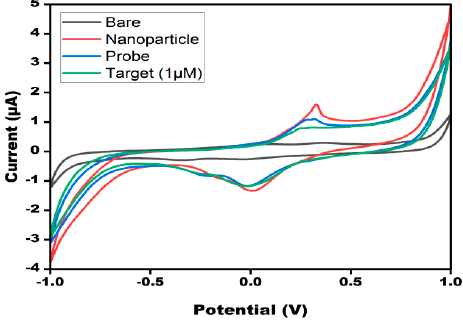
Figure 1. ( a ) XRD diffractogram and ( b ) UV-Vis spectroscopy; ( c ) TEM image of silver nanoparticles; ( d ) average particle size.